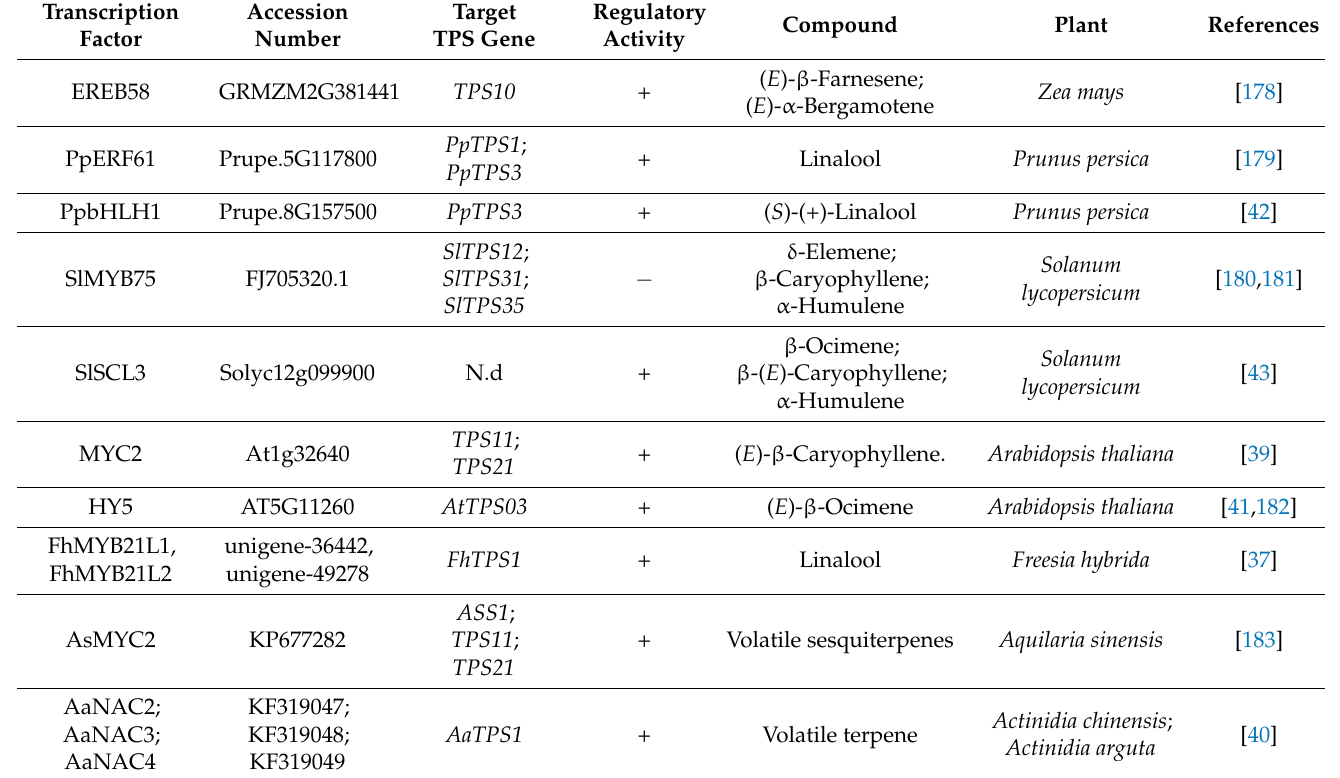
Table 1. Transcription factors regulating terpene synthesis-related genes in